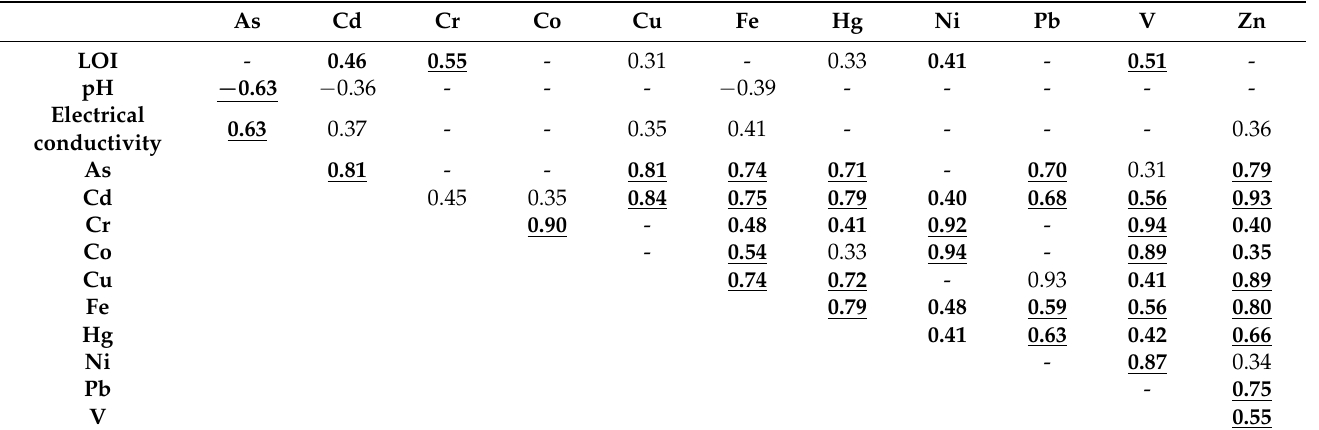
Table 7. Spearman correlations (rho values) in the sediments of the Berthelsdorf Smelter Pond ( n =